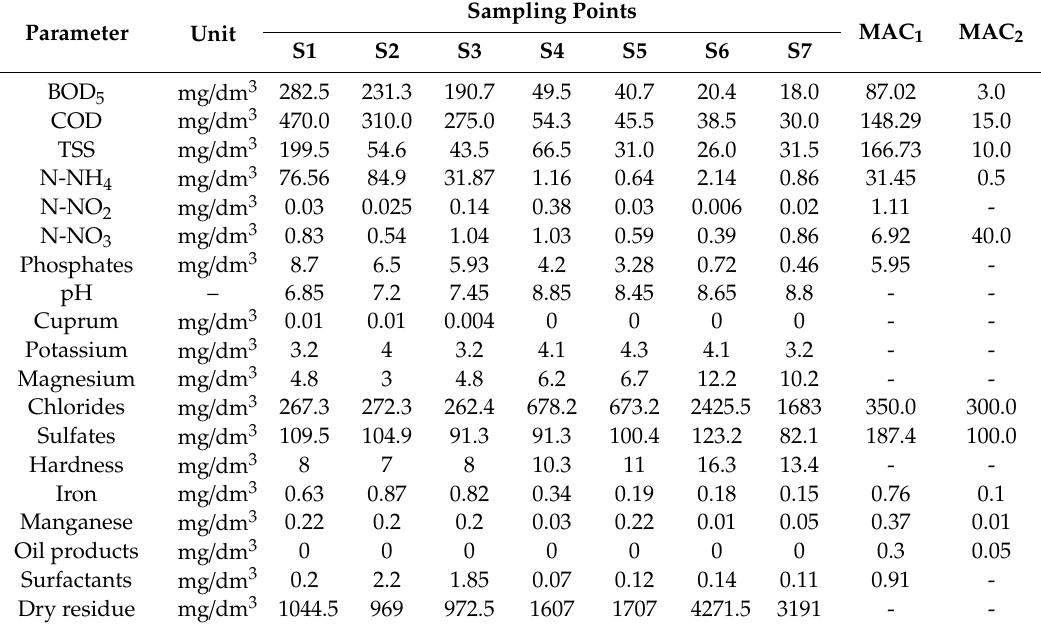
Table 2. Average values of selected wastewater quality parameters in the Kostanay wastewater treatment plant and relevant maximum allowable concentrations (MAC) values.